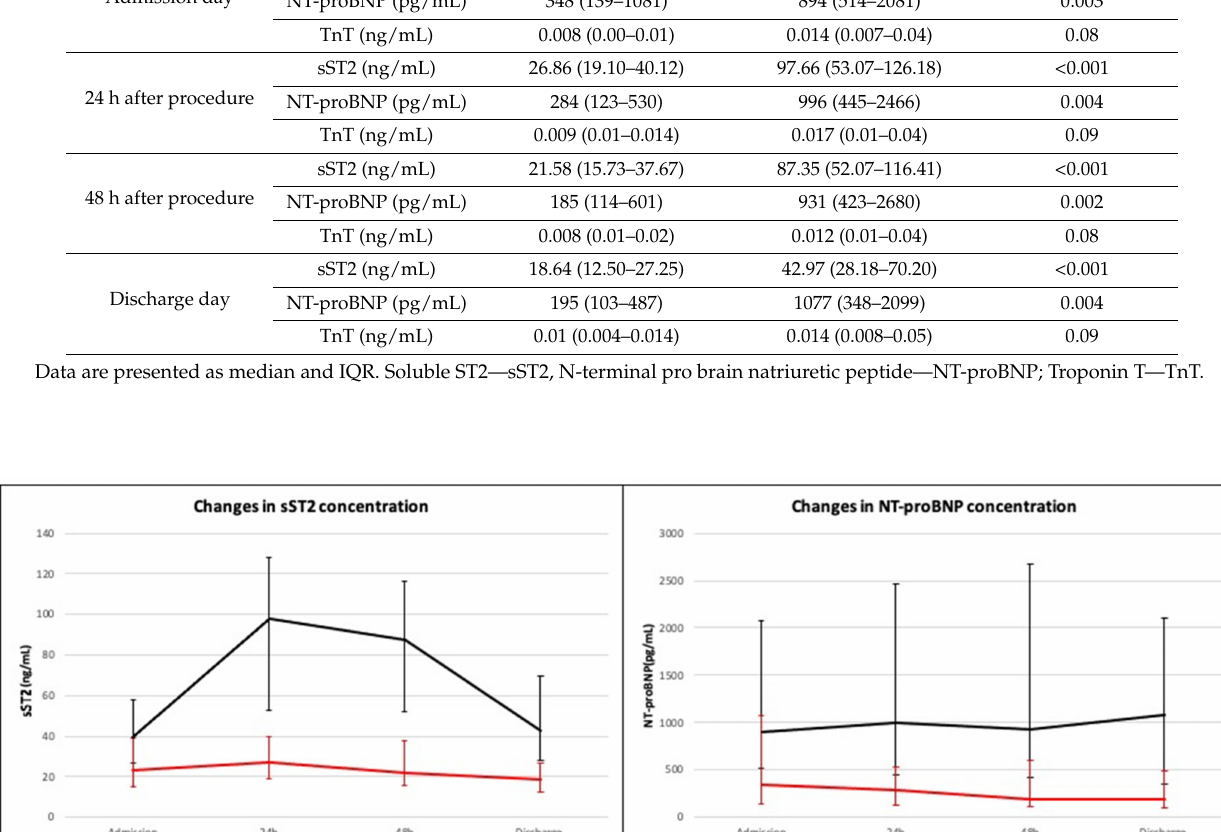
Figure 1. Changes in sST2 and NT-proBNP concentration in the groups with and without complications in the postproce- dural period.